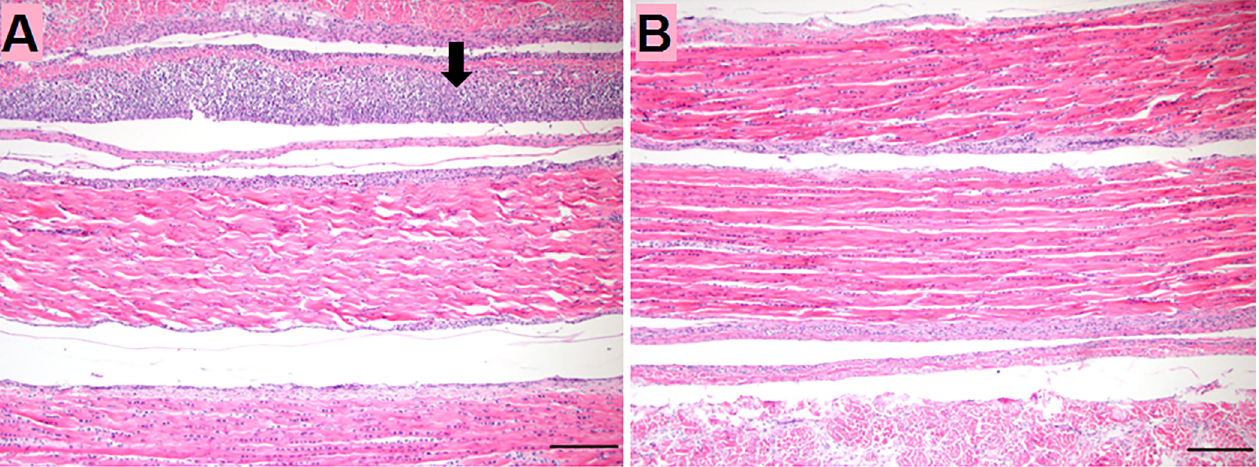
Fig 1. Histologic section in gastrocnemius tendon of turkeys at 14 dpi. (A) TARV-infected turkey at 14 dpi showing subsynovial lymphocytic infiltration (Arrow). (B) Non-infected control at 14 dpi. Bar = 100 μ